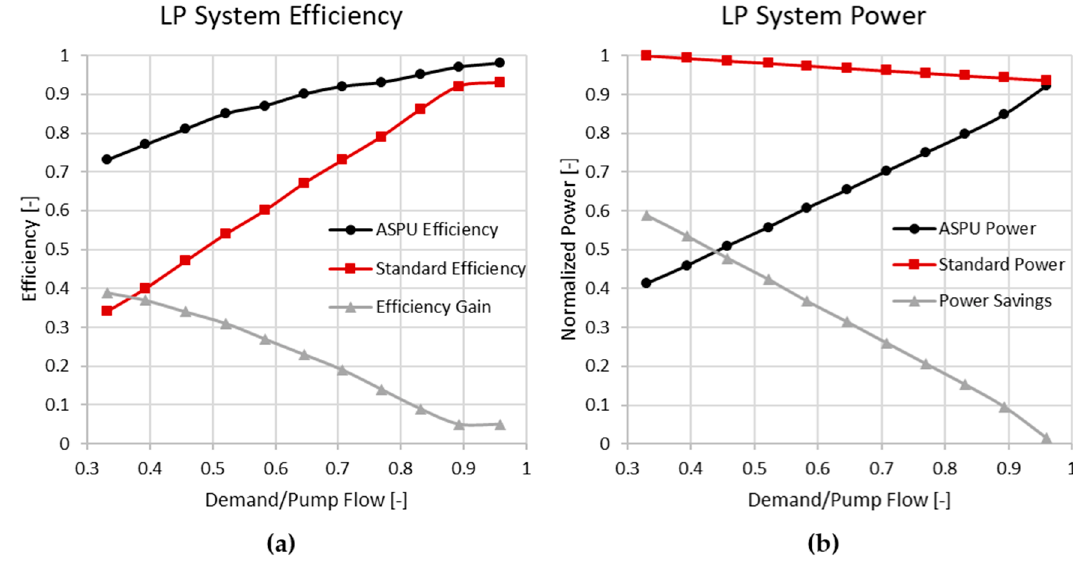
Figure 7. ( a ) Hydraulic efficiency and ( b ) power consumption versus fraction of demanded flow.